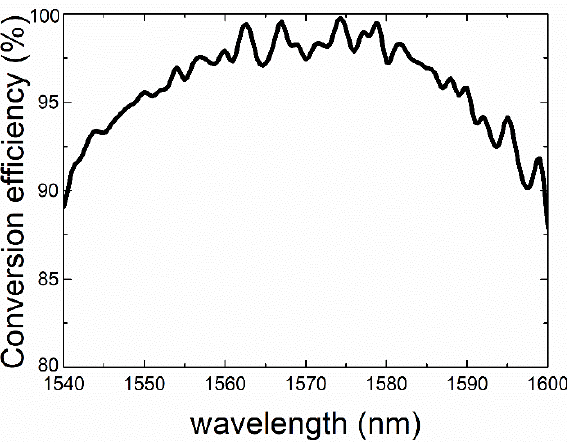
Figure 5. Conversion efficiency as a function of wavelength from 1540 nm to 1600 nm.